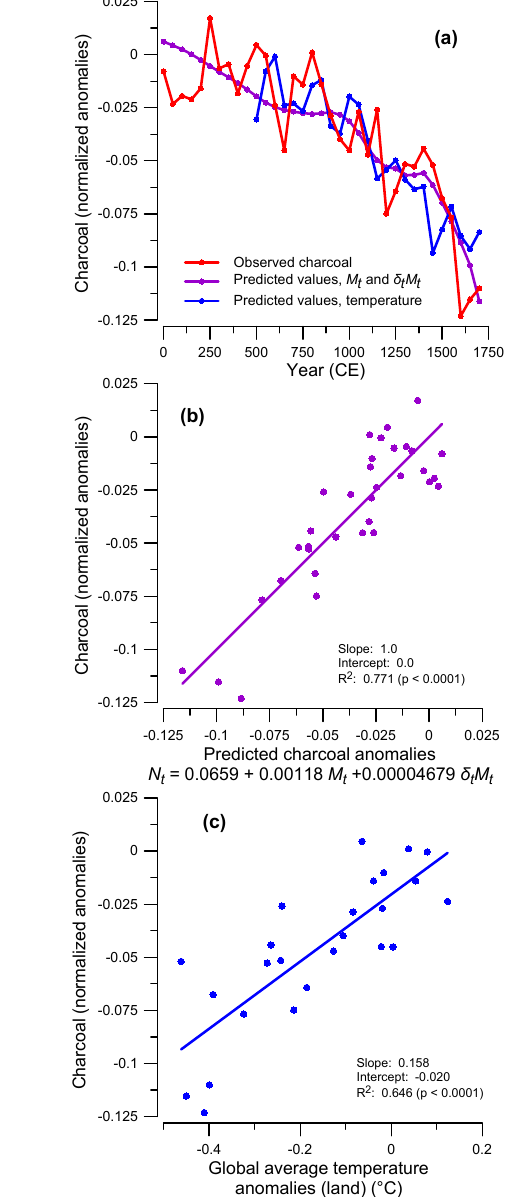
Figure 5. Relationship between normalized charcoal anomalies and global land temperature. The data points refer to 50-year binned data. The top panel (a) shows observed charcoal normans; estimated values based on the linear regression of charcoal normans against the δ 13 C of CH 4 and the product of this δ 13 C value with the con- centration of CH 4 are plotted in (b) ; and estimated values based on the linear regression of charcoal normans against temperature are plotted in (c) . Note that the slope and intercept of the relationship shown in panel (b) are necessarily 1.0 and 0.0 respectively – the key point is the goodness of fit shown between the two data sources af- ter the charcoal data have been calibrated against the CH 4 and CH 4 isotopic